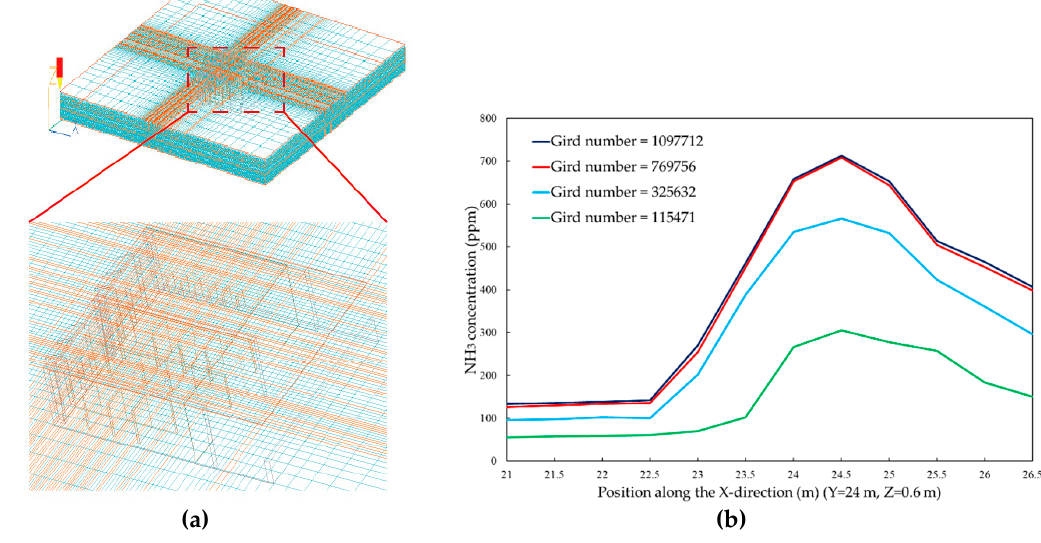
Figure 3. Calculation domain ( a ) and grid independence test results ( b ).